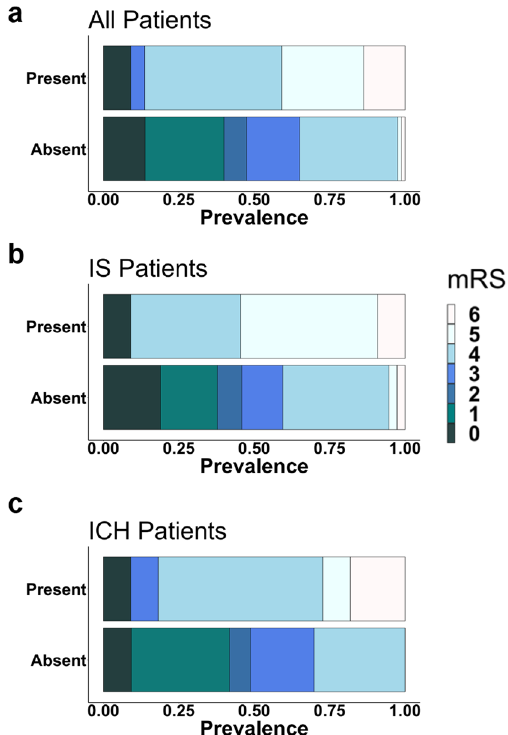
Figure 5. Modified Rankin Scale distributions for patients presenting with and without midline shift. Presence of midline shit was significantly associated with discharge functional outcome (mRS) for ( a ) all patients ( χ 2 = 34.29, p = 0.000), ( b ) ischemic stroke (IS) patients only ( χ 2 = 18.18, p = 0.006), and ( c ) intracranial hemorrhage (ICH) patients only ( χ 2 = 18.21, p = 0.006). Figure created using: (1) RStudio Team (2019). RStudio: